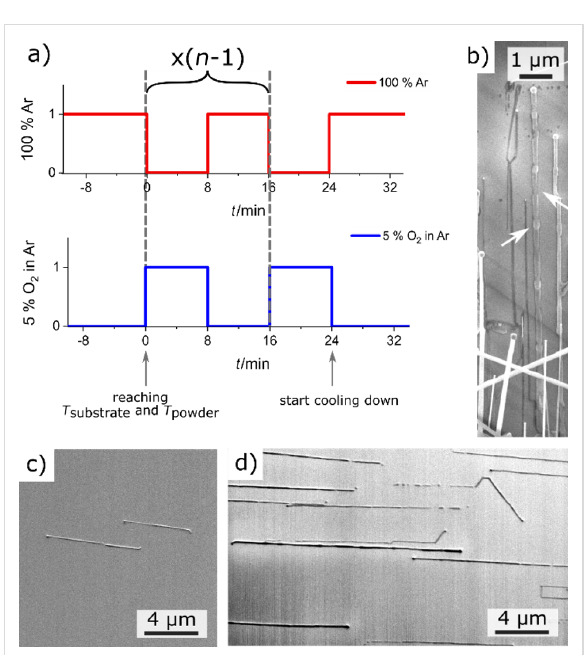
Figure 8: Pulsed gas inflow for the elongation of the NW length: (a) schematic diagram of the pulsed gas inflow with n periods and the results of the growth experiment with (b,d) 6 periods and (c) 2 periods. The residual process parameters of the growth experiments are ac- cording to our standard procedure at a process pressure of 20 mbar. In (b) a gold film edge (film thickness 5 nm) and in (c) and (d) Au NPs (Ø 80 nm) were used for an improvement of the comparability. In (a) the time t = 0 min corresponds to the time when the process tempera- ture was reached.